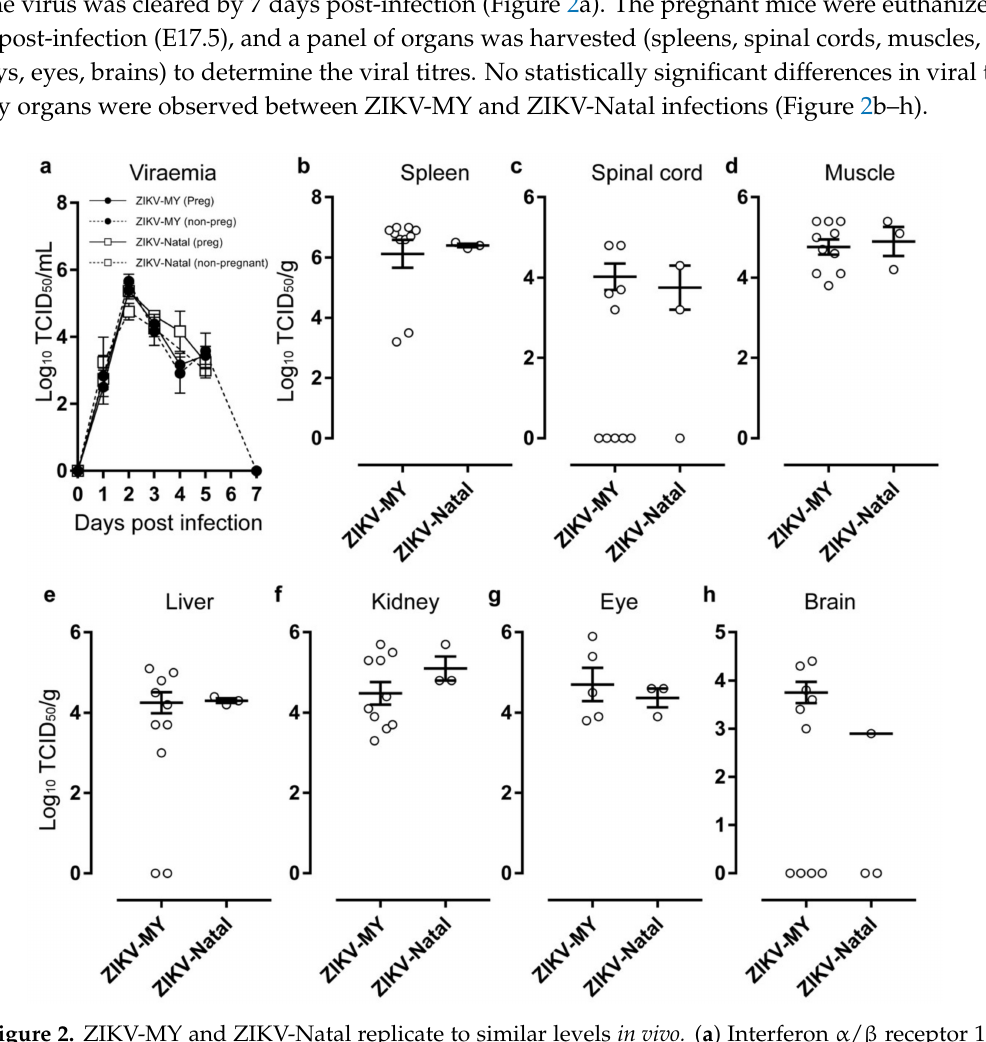
Figure 2. ZIKV-MY and ZIKV-Natal replicate to similar levels in vivo. ( a ) Interferon α / β receptor 1 knockout (IFNAR1 − / − ) C57BL/6 female mice were infected with ZIKV-MY or ZIKV-Natal. Pregnant mice were infected at E12.5 of gestation. Viremia was determined daily for five days post-infection. Pregnant mice were euthanized at E17.5, and their ( b ) spleen, ( c ) spinal cord, ( d ) muscle, ( e ) liver, ( f ) kidney, ( g ) eye, and ( h ) brain samples were processed to determine the viral titers by the CCID 50